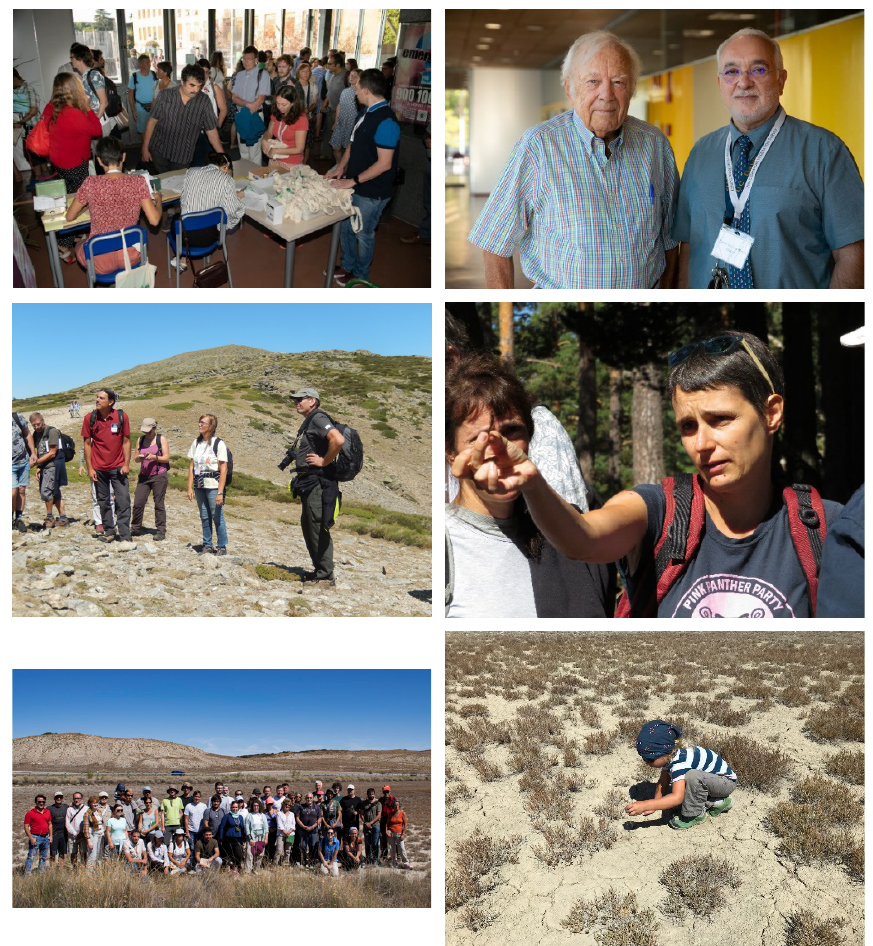
Figure 2. Some pictures from the 28 th European Vegetation Survey. From up to down and left to right. Left, Starting the meeting: Registration desk; right, Professors Wolfredo Wildpret de la Torre and Daniel Sánchez Mata answered questions to a UCM journalist on vegetation conservation problems in Canary Islands. Excursion to Sierra de Guadarrama National Park: left, José Luis Izquierdo and Rosario G. Gavilán explaining Festuca curvifolia (carpetana) grasslands, Peñalara peak at the bottom; right, Alba Gutiérrez Girón leading one of the groups. Excursion to southeastern Madrid (El Salobral): left, group picture; right, learning on plants and vegetation from childhood! (J. Sibik